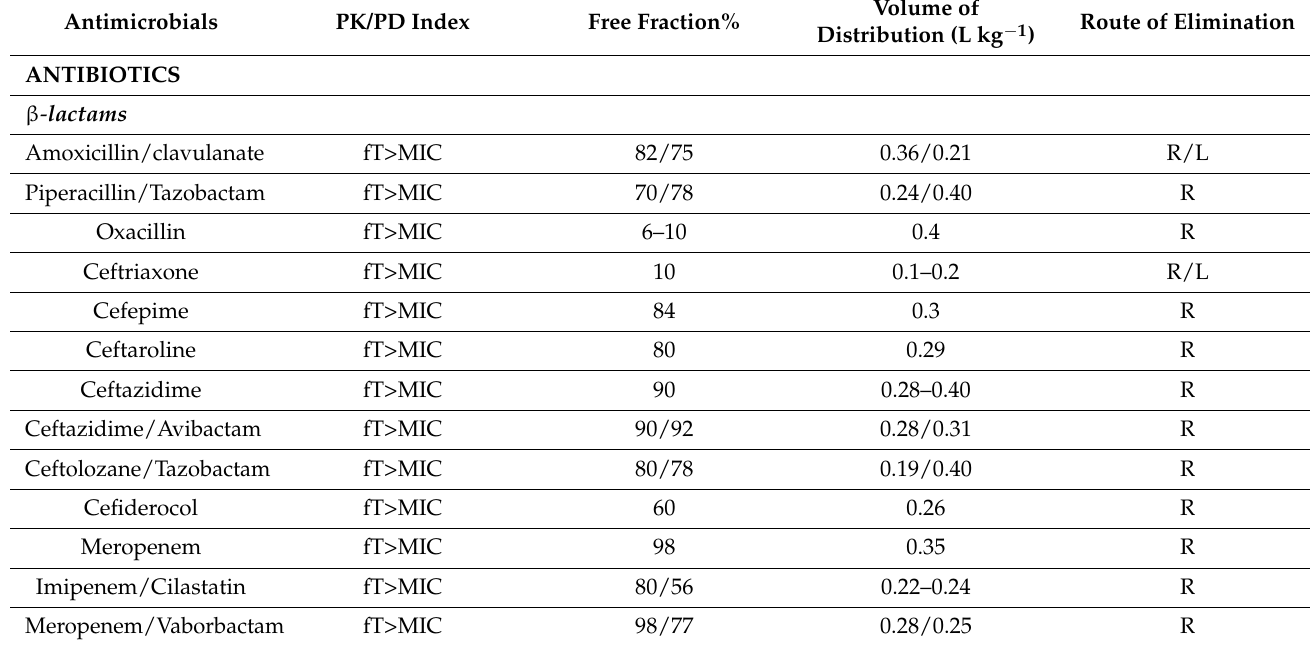
Table 1. PK/PD characteristics of